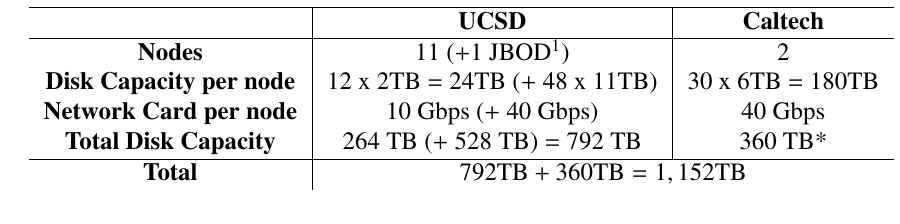
Table 2. Hardware deployment specification for SoCal